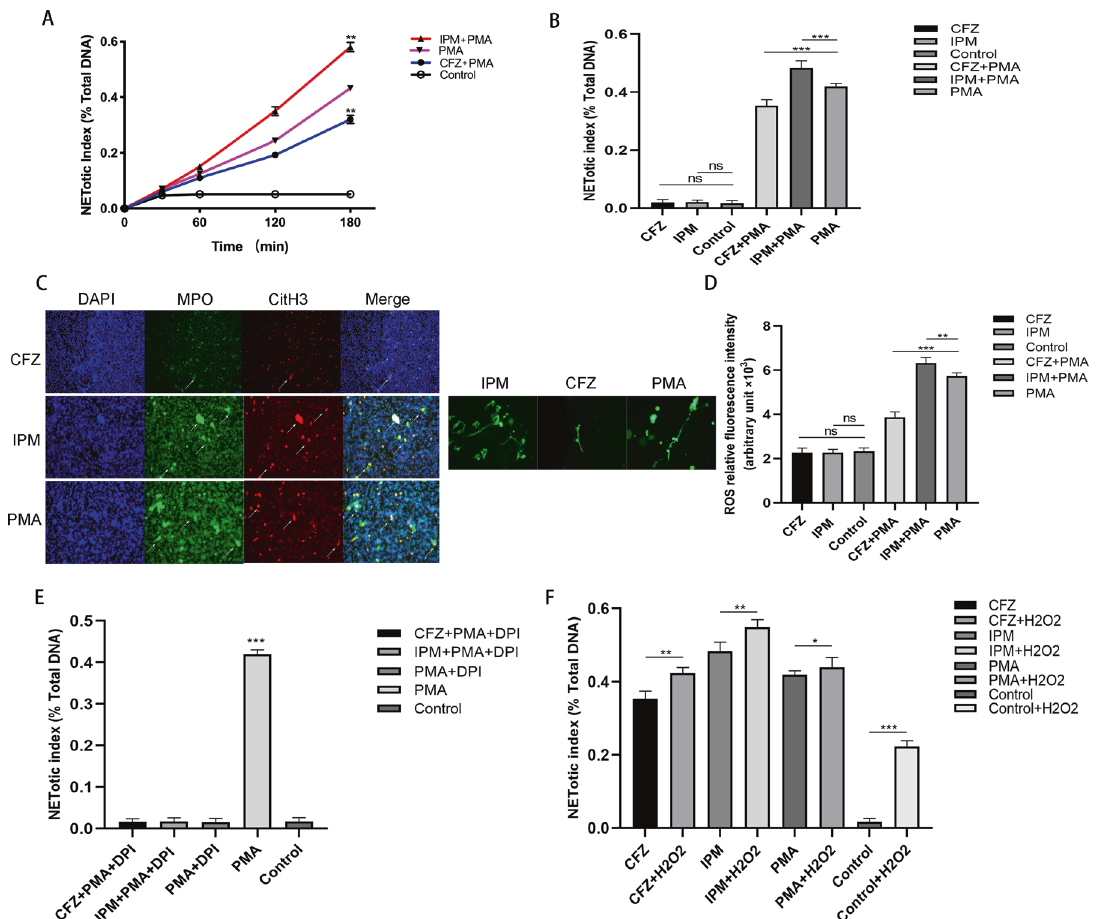
Fig. 6 The effects of antibiotics on ROS generation and NETs formation. Human peripheral neutrophils were preincubated with antibiotics or PBS for 2 h and stimulated to form NETs with or without PMA (100 nM) for 3 h. A Kinetics of NETs releasing in PMA-stimulated neutrophils was recorded ( n = 3). B NETs release in activated (with PMA) or resting (antibiotics alone) neutrophils was measured using Sytox Green fl uorescence plate reader assay at 3 h and expression as the ratio of the percentage of total DNA ( n = 3). Both antibiotics group showed effects on the NETs formation only in activated neutrophils. C To further con fi rm the existence of NETs, neutrophils were preincubated with antibiotics or PBS for 2 h and stimulated to form NETs with PMA (100 nM) for 3 h. DNA (blue) stained with DAPI, MPO (green) stained with anti- MPO antibody, and citH3 (red) stained with anti-citH3 were counterstained in neutrophils for immuno fl uorescence. DNA stained with Sytox Green alone in neutrophils for immuno fl uorescence to show the morphology of NETs. D Neutrophils were preincubated with β -Lactams (2 mM) for 2 h and then treated with or without PMA. Intracellular ROS were measured with DHR123 at 45 min ( n = 3). E Neutrophils pre- cultivated with DPI, an NADPH oxidase inhibitor, were incubated with β -Lactams for 2 h and then activated with PMA. The ROS production was measured using DHR123 fl uorescence plate reader assay at a time of 45 min ( n = 3). F To con fi rm the role of ROS, exogenous H 2 O 2 (30 μ M) was added after 2-h incubation with β -Lactams. NETosis was measured using Sytox Green fl uorescence plate reader assay at the time of 3 h and expression as relative fl uorescence unit ( n = 3). Images are representative of three independent experiments. Bars were shown in the fi gure; data were analyzed by Student ’ s t -test. * P < 0.05, ** P < 0.01, *** P < 0.001, ns no signi fi cance. DE de-escalation. ES